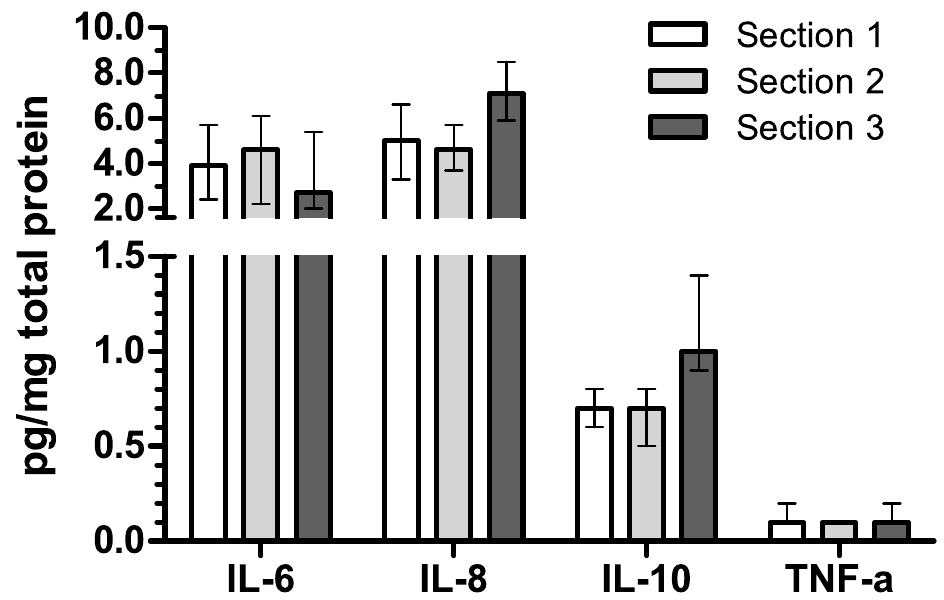
Fig 2. Biomarker concentrations across placental collection approaches. Data are median (25 th , 75 th percentile) in pg/mg total protein. Sections 1 (full thickness) and 2 (excised middle portion prior to freezing) were obtained within 40 minutes of delivery and snap frozen in liquid nitrogen. Section 3 (full thickness) was obtained after refrigerating the placenta at 4˚C for 24 hours, and placed into -80˚C freezer after samples were obtained. From each of the 10 placentae used to compare collection approaches, there were three lysates produced for each collection condition, and each lysate was assayed five times. Therefore, each individual placenta contributed 15 of each cytokine measurement per collection